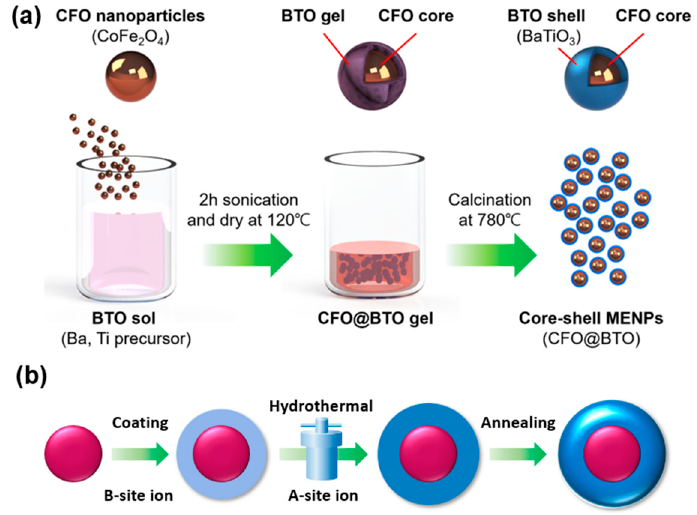
Figure 3. Widely adopted fabrication methods of MENPs with core–shell structure. ( a ) Preparation of CoFe 2 O 4 @BaTiO 3 (CFO@BTO) MENPs using the sol–gel method. Reproduced with permission from [45]. Copyright 2022, Royal Society of Chemistry. ( b ) Synthesis of core–shell MENPs employing the hydrothermal method. Reproduced with permission from [67]. Copyright 2010, Royal Society of